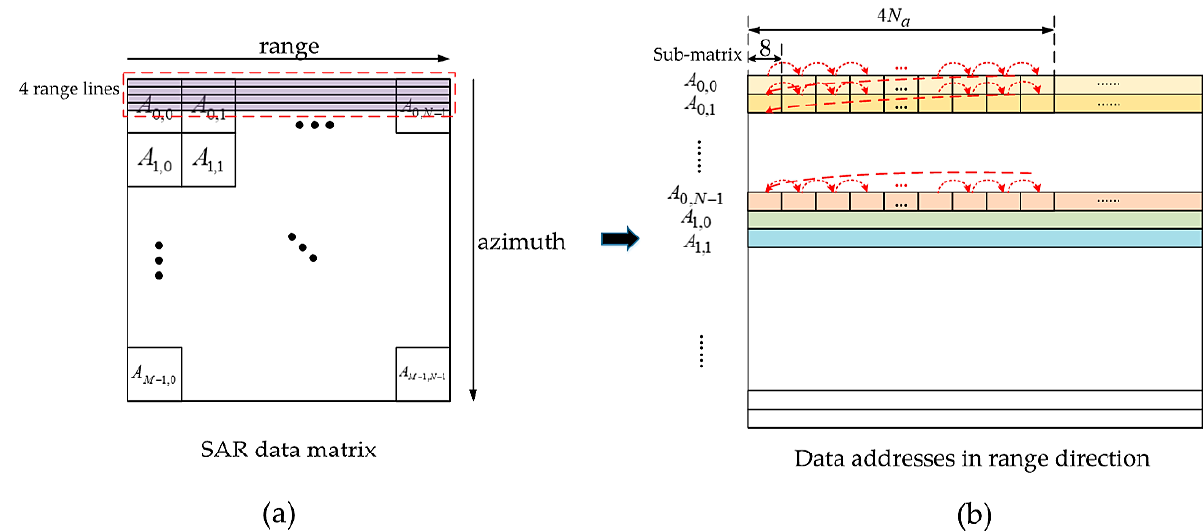
Figure 9. Data access address change method in range direction. ( a ) The four range lines to be accessed in the SAR data matrix; ( b ) the physical addresses of the four range lines to be accessed in DDR3 (each cell represents eight burst transmission data in DDR3; the red dotted line represents the data access sequence in